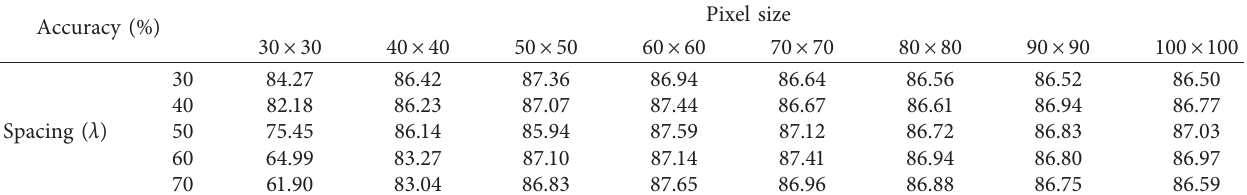
Table 10: The classification accuracy in the standard N-D 2 NN model corresponds to pixel size and diffraction grating spacing. Accuracy